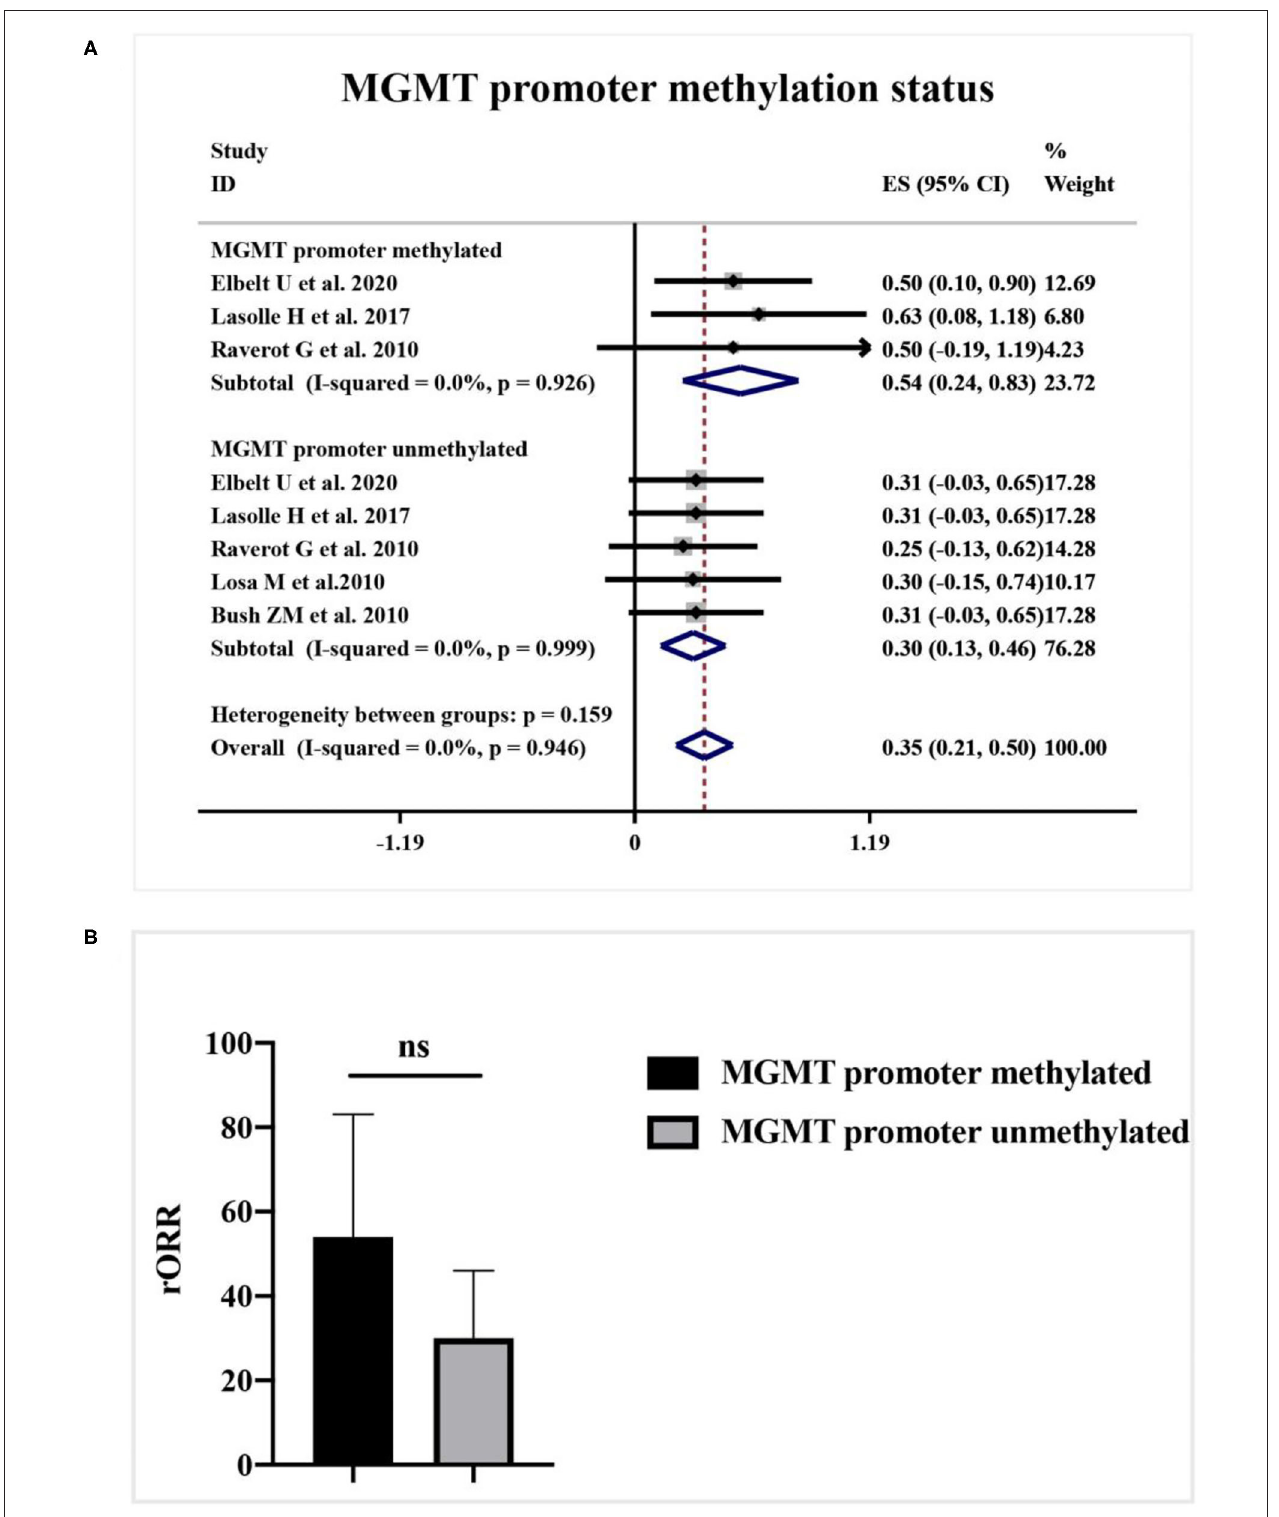
FIGURE 5 | The correlation between MGMT promoter methylation status and TMZ radiological response. (A) Radiological response rate was 54% in the MGMT promoter methylated group, and 30% in the unmethylated group. (B) The quantitative histogram showed the difference between groups was not significant.